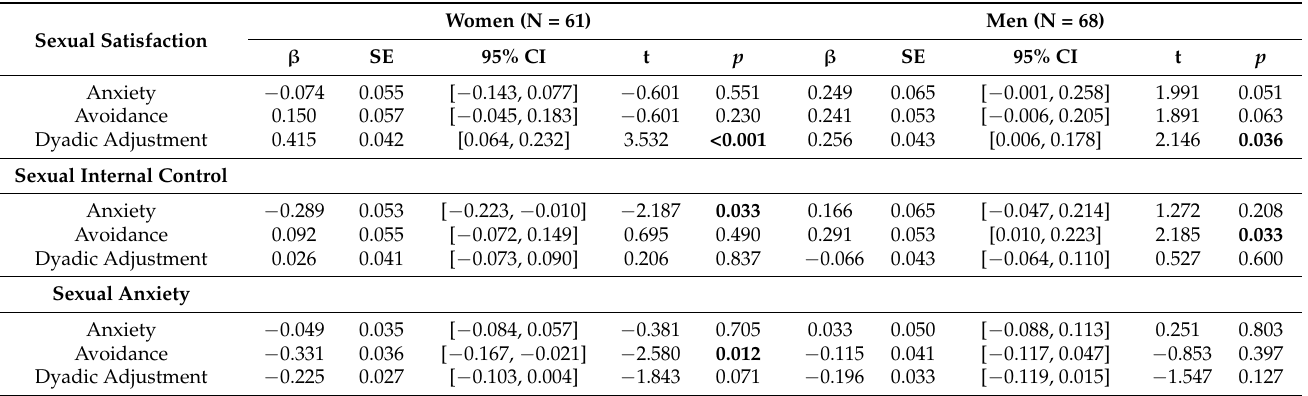
Table 6. Linear regressions with sexual dimensions as dependent variables and attachment and dyadic adjustment as independent